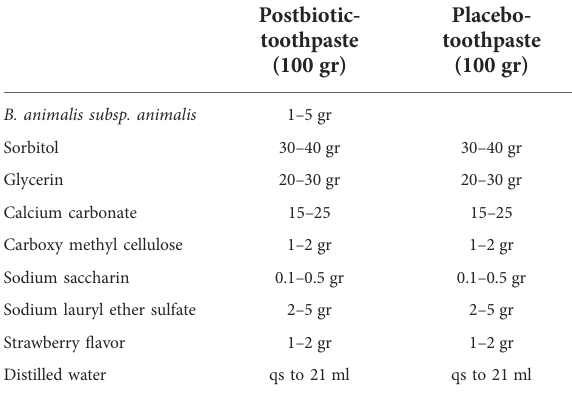
TABLE 1 List of the ingredients of each